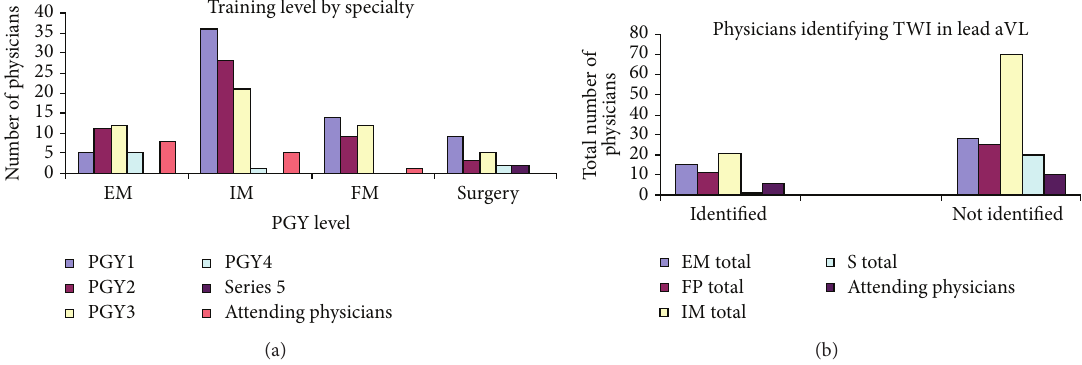
Figure 2: (a) Number of physicians by training level and specialties. (b) Total number of physicians who identified TWI in lead aVL on ECG by training level and